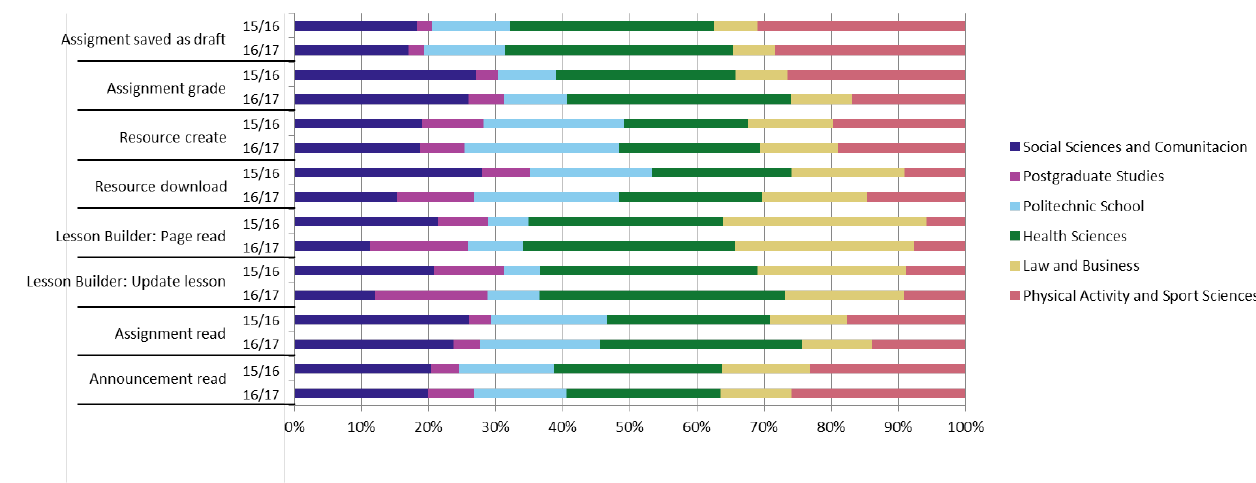
Figure 2. Ranking of events per lecturer (in percentage) related to the on-campus modality for the academic years 2015/16 and 2016/17.